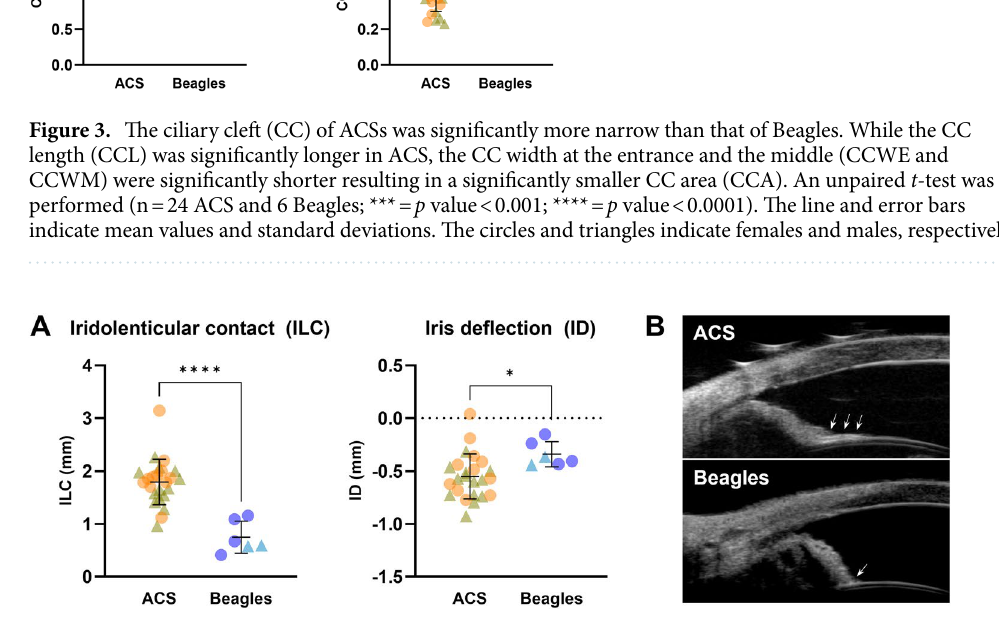
Figure 4. The iris of the ACS was significantly more in contact with the anterior lens capsule and more concave (posteriorly deflected) in comparison to the Beagles. ( A ) The ACS have significantly longer iridolenticular contact (ILC) with a greater degree of posterior iris deflection (ID) versus Beagles. An unpaired t -test was performed (n = 24 ACS and 6 Beagles; * = p value < 0.05; **** = p value < 0.0001). The line and error bars indicate mean values and standard deviations. The circles and triangles indicate females and males, respectively. ( B ) Representative UBM images of ACS and Beagles are shown. Arrows indicate the iris in contact with the anterior lens